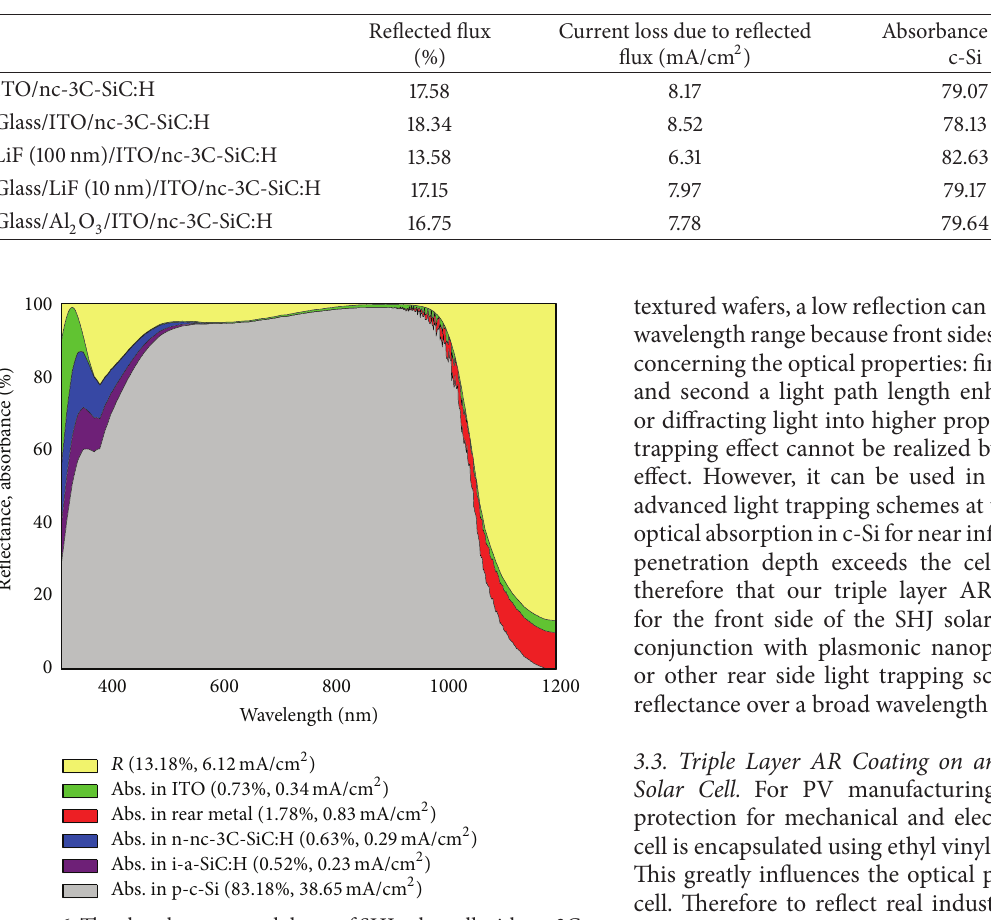
Table 2: Comparative result of the total reflectance and the total absorbance in each layer with different AR coating schemes and emitter layer for flat SHJ solar cell. The thicknesses of AR coating and emitter layers are optimized values.